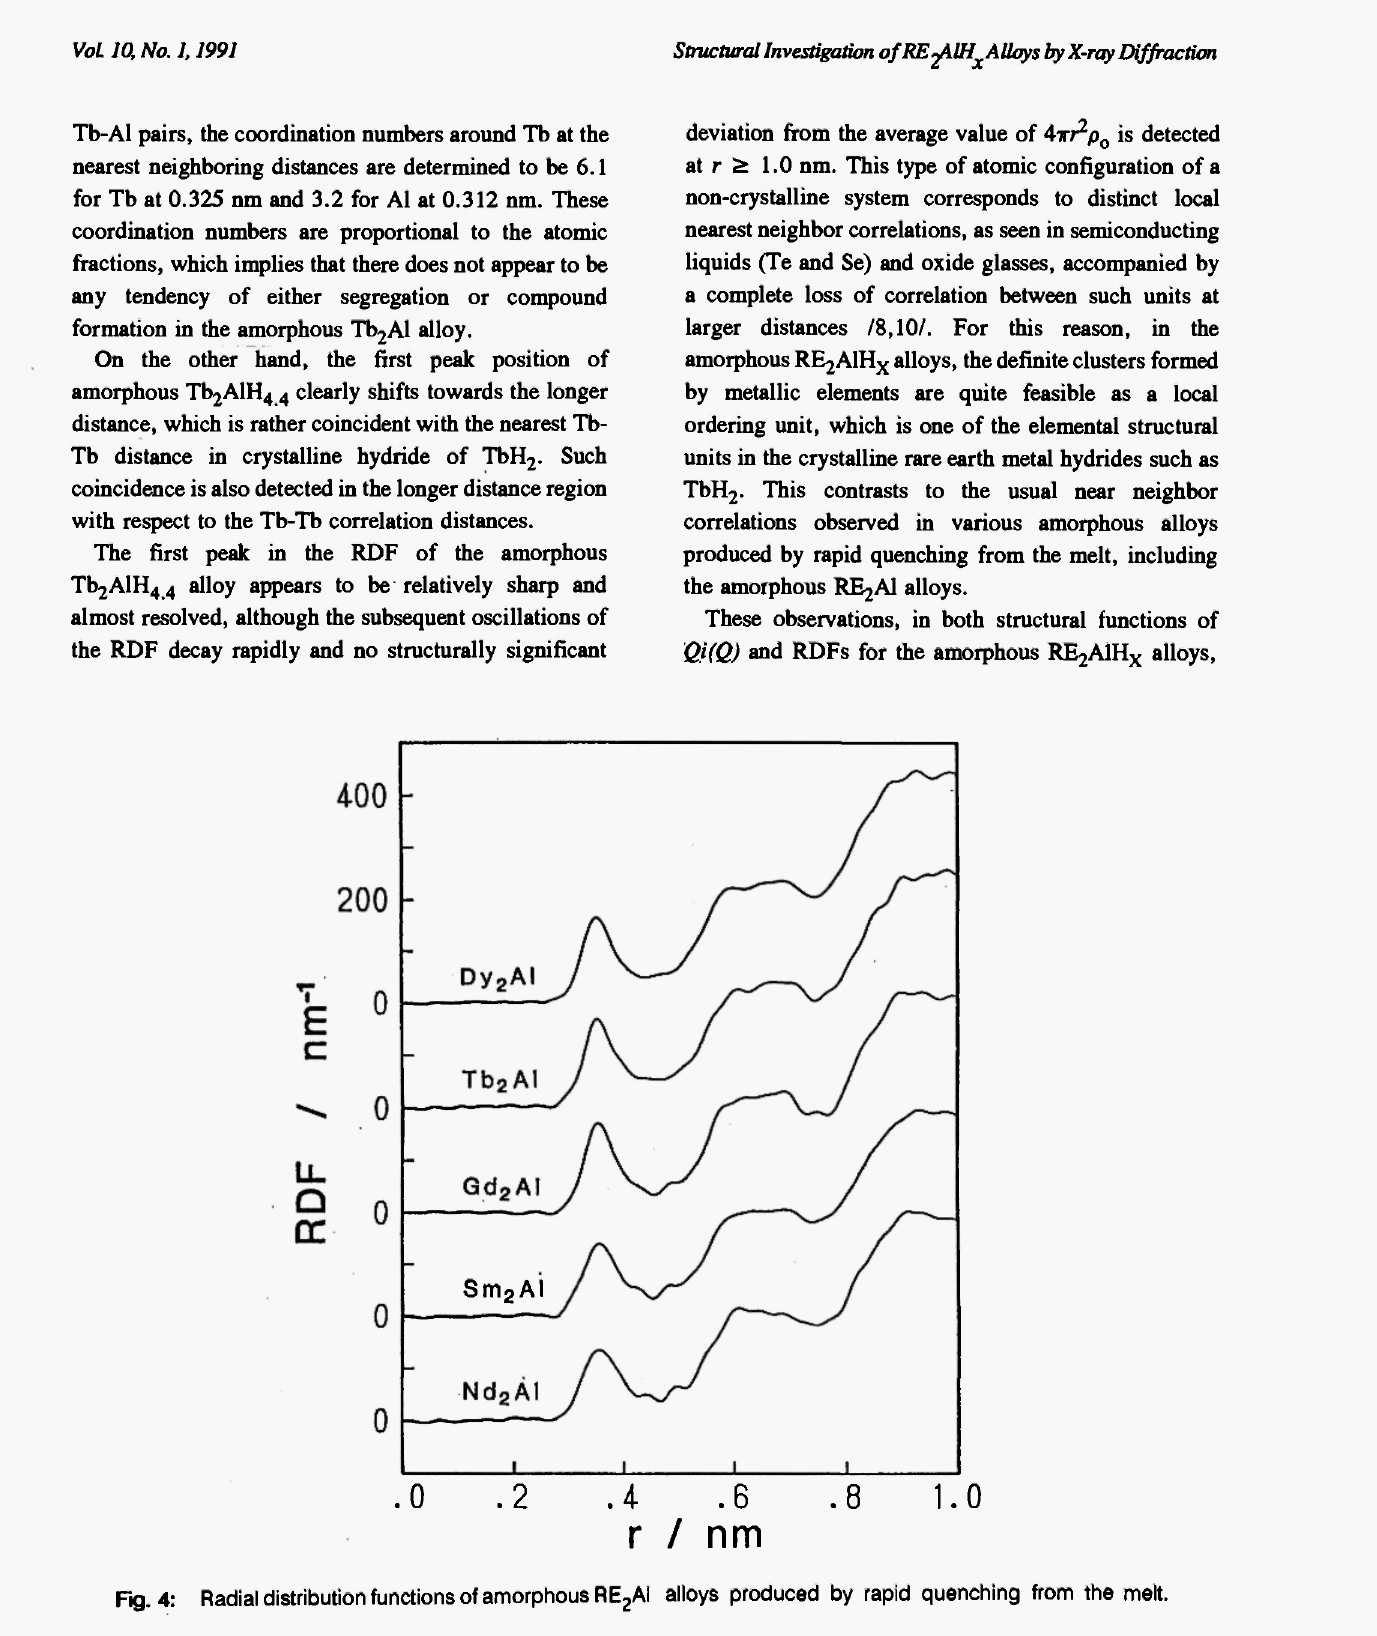
Fig. 4: Radial distribution functions of amorphous RE 2 AI alloys produced by rapid quenching from the melt.